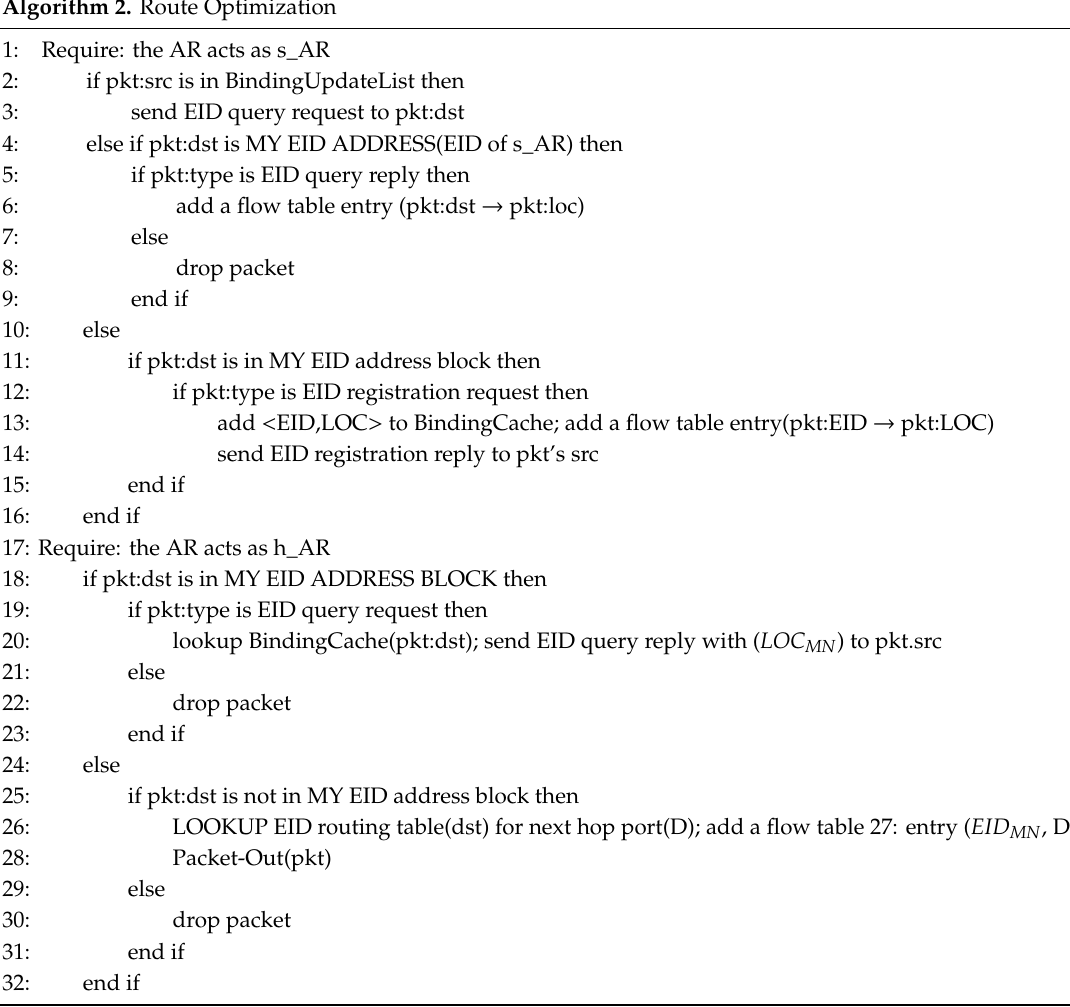
Algorithm 2. Route